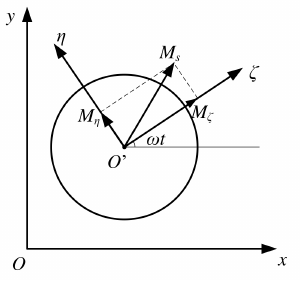
Figure 11. Schematic diagram of additional bending moment of